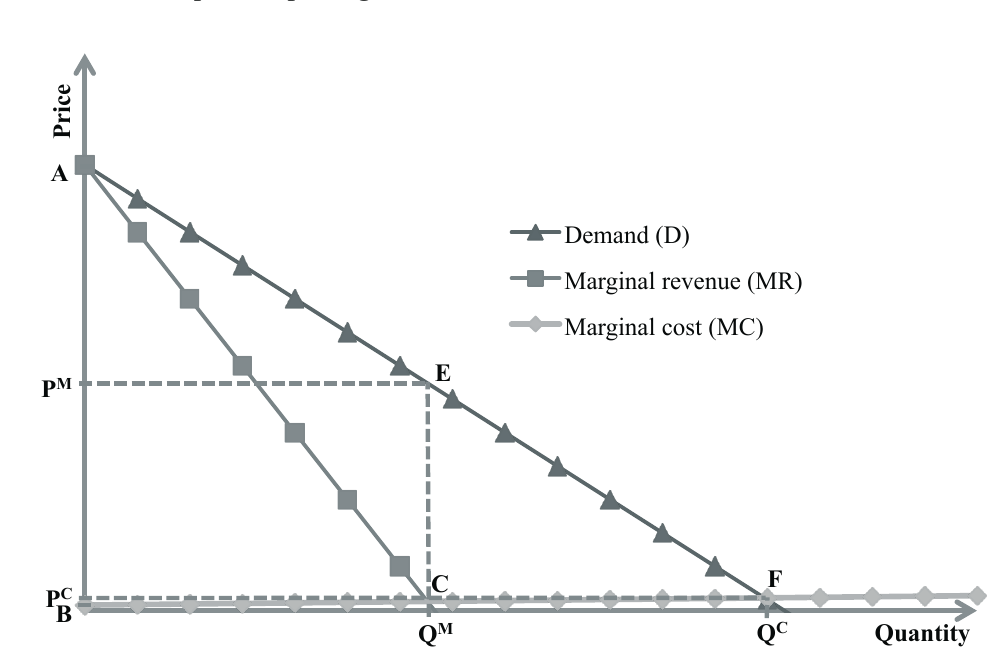
A stylised example of supply and demand illustrating monopoly and competitive